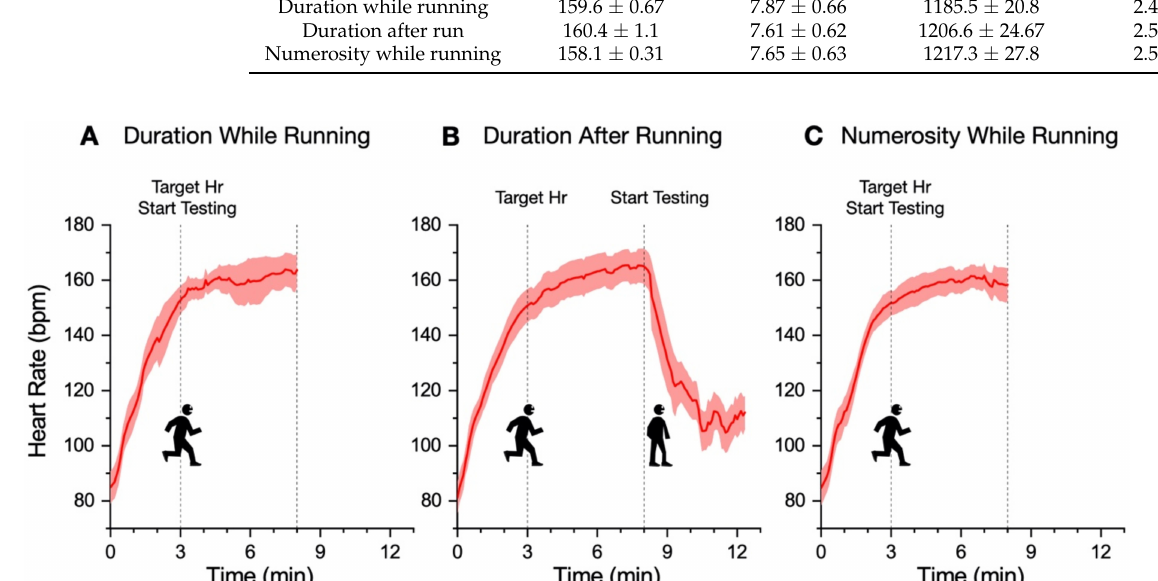
Figure 2. Heartrate parameters. Average heart rate with ± 95% C.I. as a function of time after running onset. In all the experiments ( A – C ), the heart rate gradually reaches the target value (see methods) within 3 min, then remains stable around that value for the subsequent 5 min of